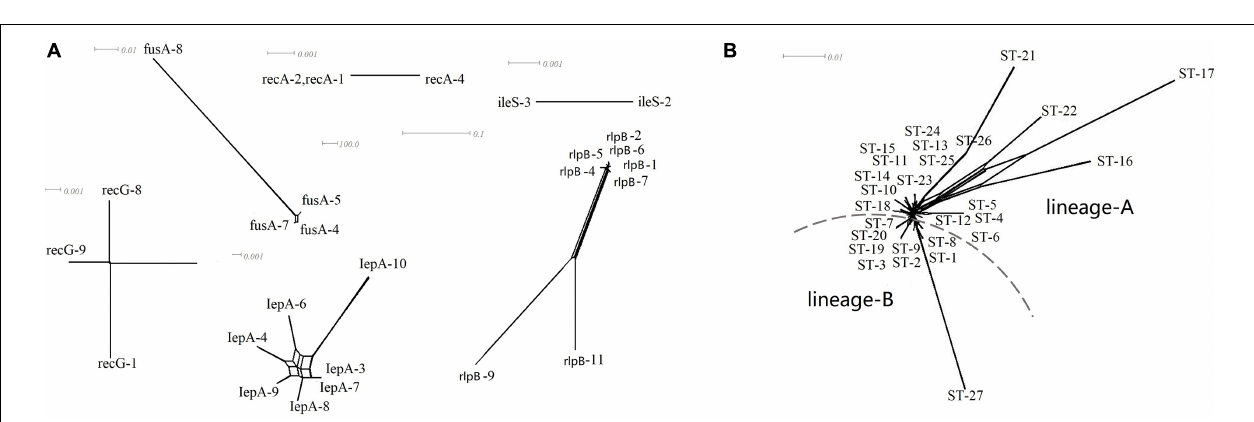
FIGURE 5 | (A) Single housekeeping gene split tree diagram of L . paracasei , (B) split decomposition analysis of L . paracasei based on concatenate sequences of seven housekeeping